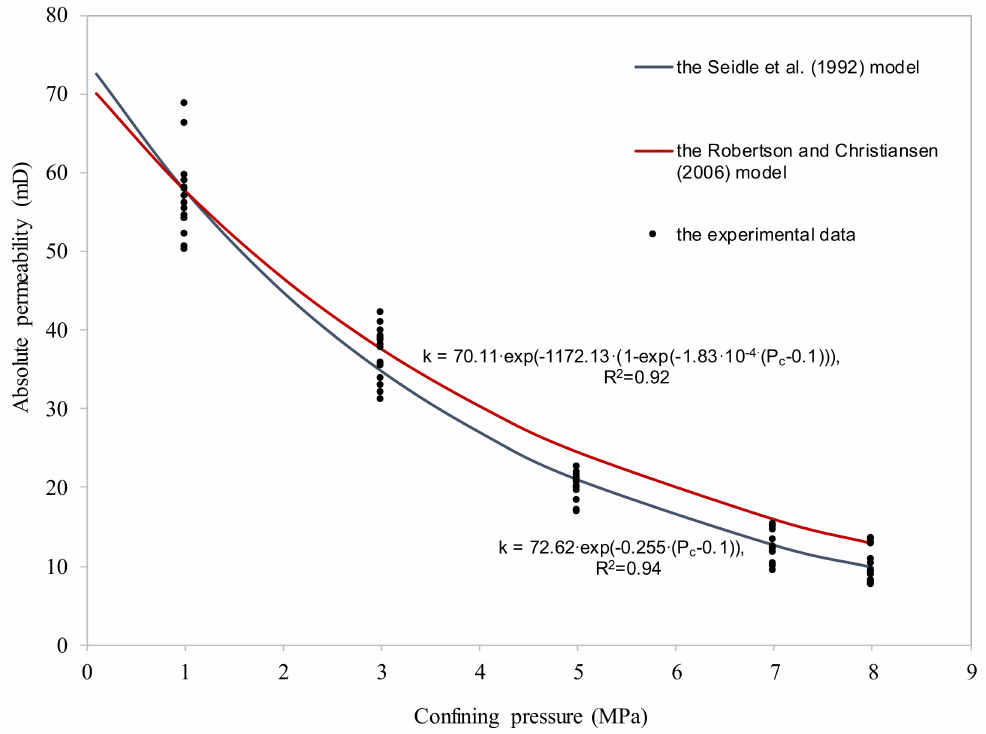
Figure 6. Dependence of the gas permeability coefficient of the coking coals (S. D. Tihov mine, Leninsky area, Kuzbass) (k) on the hydrostatic confining pressure